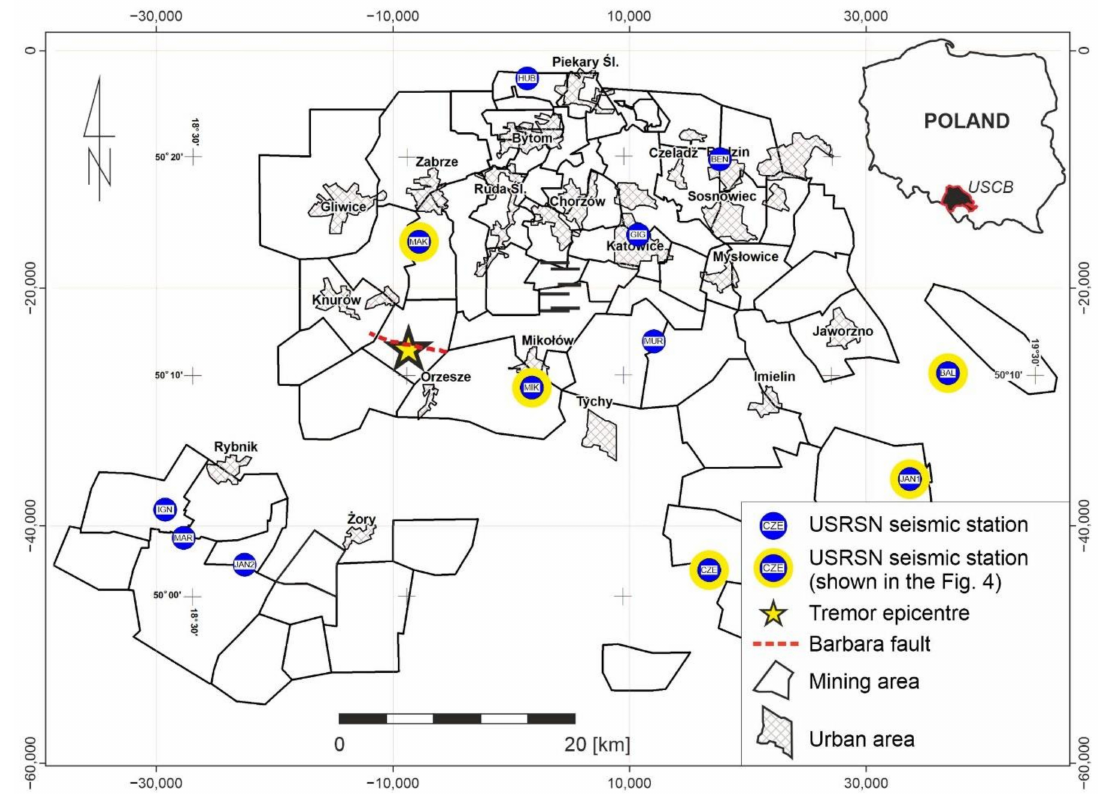
Figure 1. Map of mining areas in the Upper Silesian Coal Basin with the location of the tremor source of 8 November 2018, with seismic energy E = 4.0 · 10 8 J and seismic stations of the Upper Silesian Regional Seismological